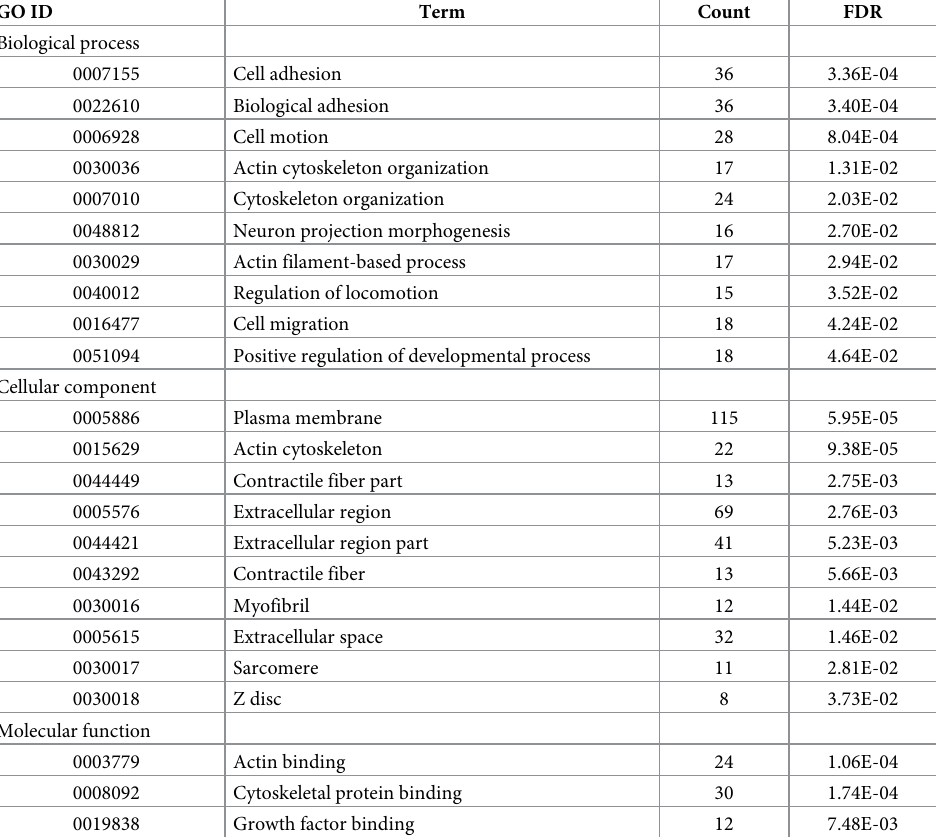
Table 2. The GO analysis of predicted target genes of LINC00922. GO ID Term